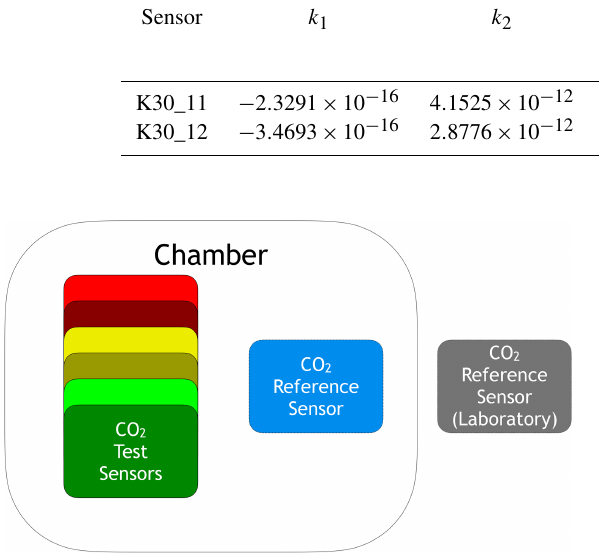
Figure 4. Diagram for the sensor placement during the temperature and relative humidity experiments at the Oklahoma Mesonet Cali- bration Laboratory. Six test sensors were placed inside the chamber with a reference sensor, and another reference sensor was placed outside to detect possible